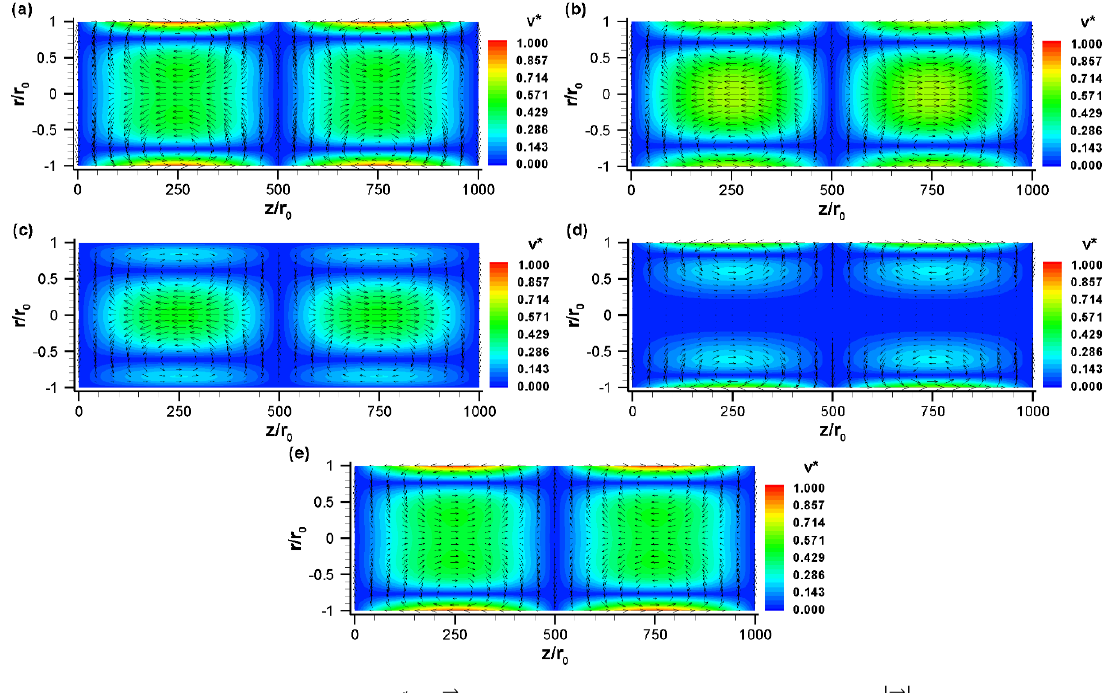
→ ∗ → v V u  (vector plot), and its magnitude, * Figure 3. The normalized velocity, * = v V / u HS (vector plot), and its magnitude, v ∗ = Figure 3. The normalized velocity, HS (contour plot), with sinusoidal zeta potential distribution at various nondimensional times: ( a ) plot), with sinusoidal zeta potential distribution at various nondimensional times: ( a ) ω t = π /2, 2 t   , ( b ) 3 4 t   , ( c ) t   , ( d ) 5 4 t   , and ( e ) 3 2 t   . The vector plot ( b ) ω t = 3 π /4, ( c ) ω t = π , ( d ) ω t = 5 π /4, and ( e ) ω t = 3 π /2. The vector plot shows the direction of fluid motion whereas the contour plot shows the magnitude of the velocity. Here, u HS = − εζ E 0 / µ , shows the direction of fluid motion whereas the contour plot shows the magnitude of the velocity. E 0 = 10 kV/m, ζ 0 = − 100 mV, r 0 = 50 µ m, L = 5 cm, q = 2 π / L , f = 1.6 kHz ( Ω = 25). Fluid properties are taken for water at 20 ◦